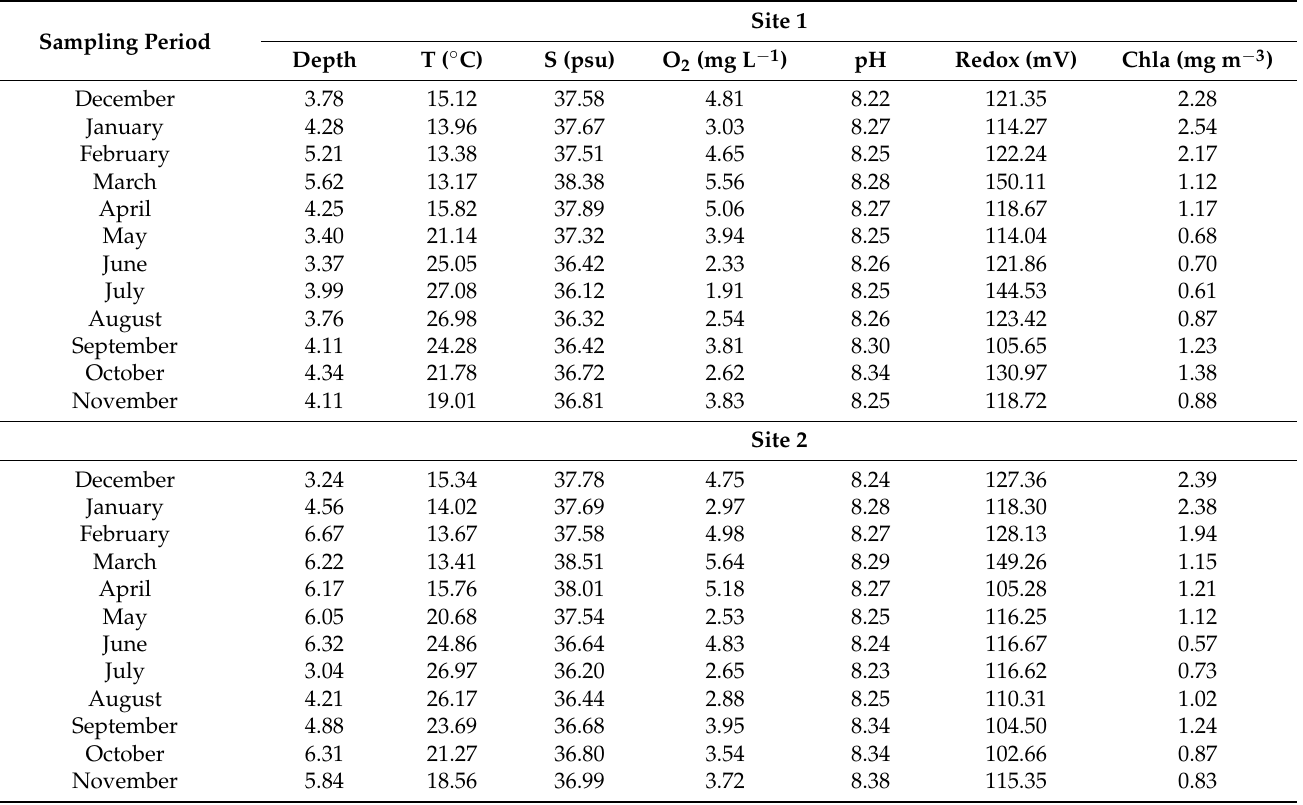
Table 1. Physical (T, temperature; S, salinity) and chemical (O 2 , dissolved oxygen; pH, Redox potential; Chla, Chlorophyl-a) variables recorded in the Pagasitikos Gulf (Site 1 Agios Stefanos, Site 2 Kato